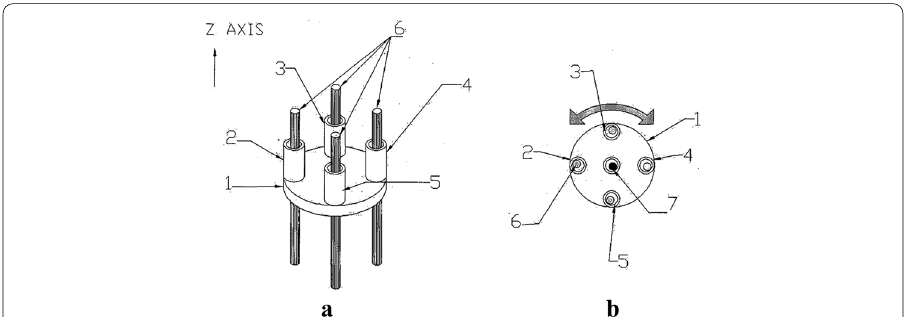
Fig. 9 Rotating disks (Kale 2015). a Isometric view, b top view. 1—disk, 2–5—thread guides, 6—warp threads, 7—extra non-interlacing warp